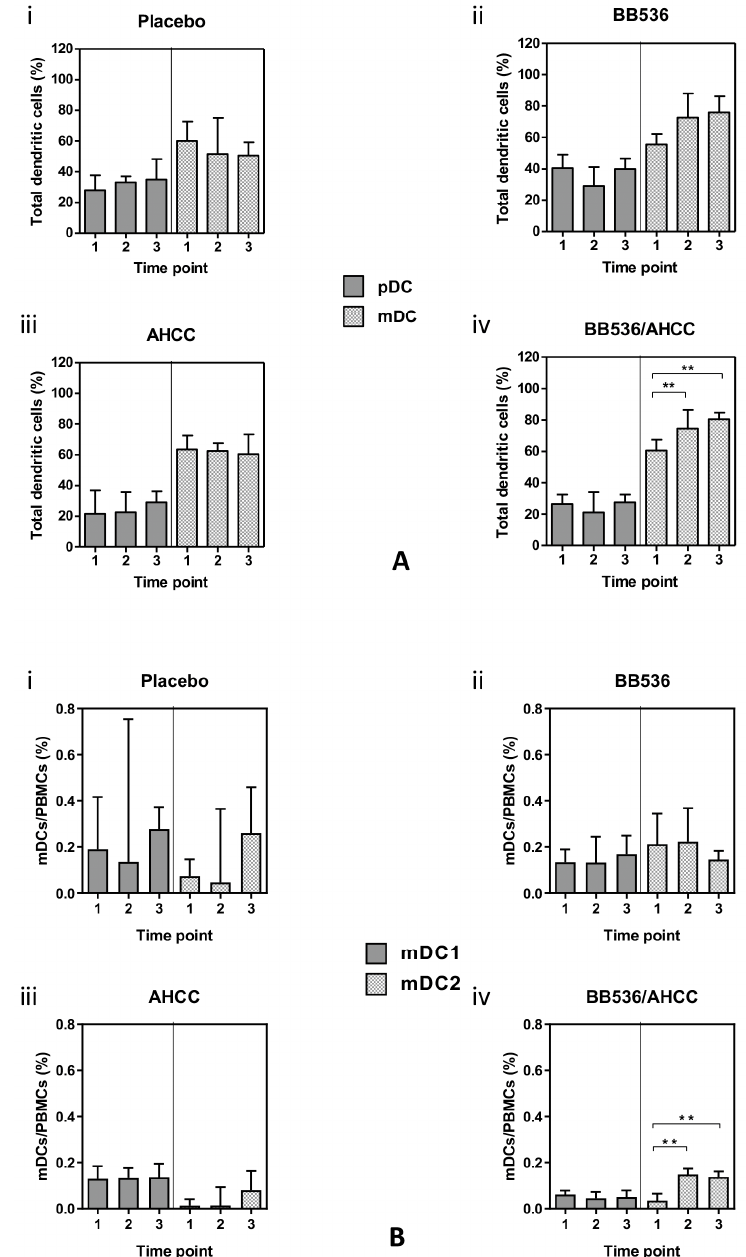
Figure 3. ( A ) Characterisation of DC subsets based on expression of CD11c as a percentage of total mDCs. ( B ) Characterisation of myeloid dendritic cell subsets as a percentage of total PMBCs. Values represent mean (SEM). Significance calculated using the Student t test (paired). BB536: Bifidobacterium longum ; AHCC ® : a standardized extract of cultured Lentinula edodes mycelia; **: p < 0.01. Time points: